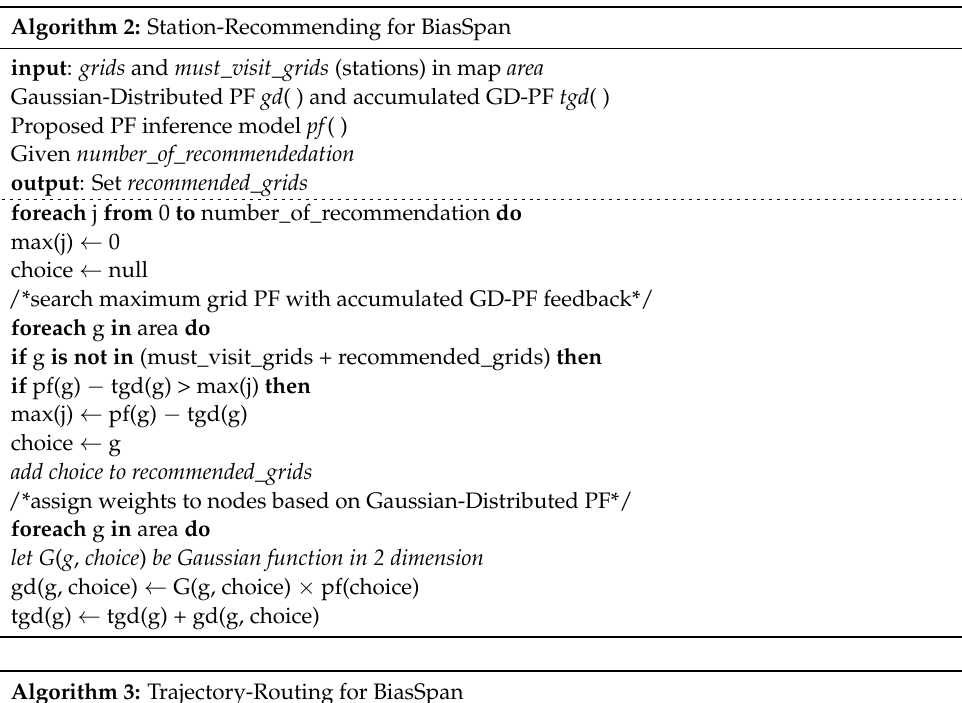
Algorithm 2: Station-Recommending for BiasSpan